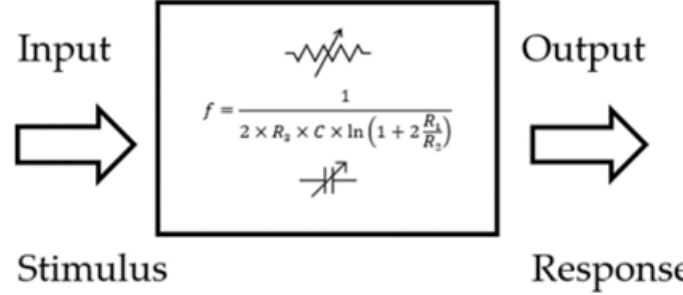
Fig. 4. Core game loop for Circuit Warz